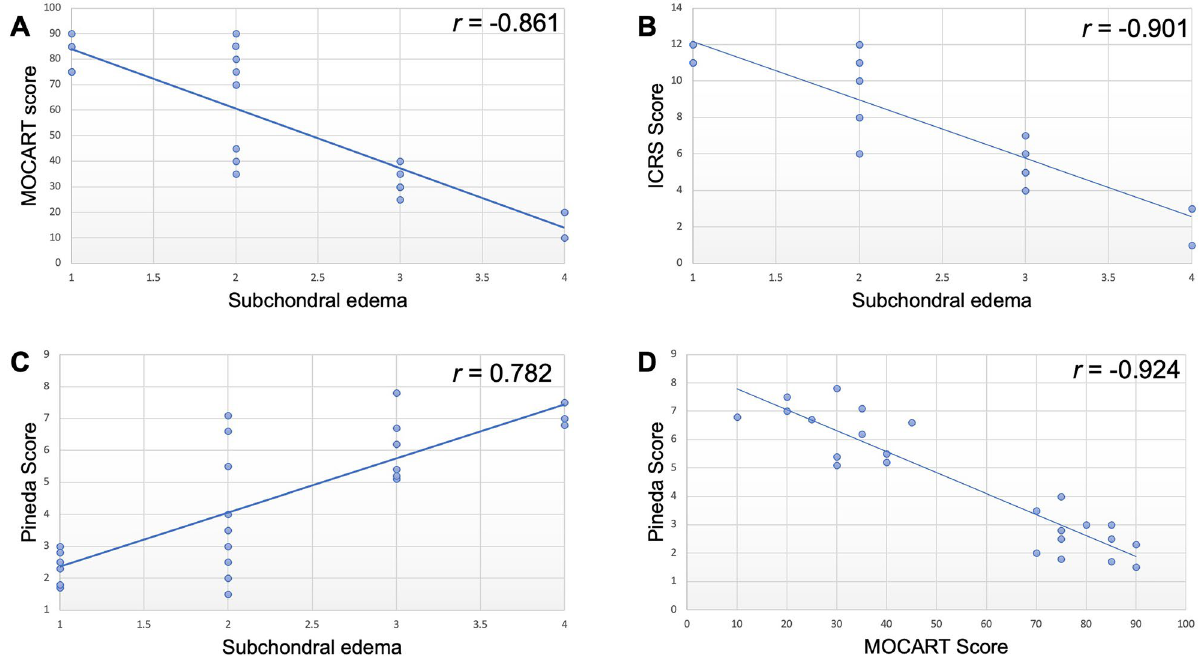
Figure 3. Correlation of quantitative scores for subchondral edema at 2 weeks after MASI with quantitative scores for cartilage repair (MOCART score, ( A ) and ICRS score, ( B )) at 12 weeks and Pineda scores at 24 weeks ( C ) and correlation of the quantitative scores for Pineda scores at 24 weeks with quantitative scores for cartilage repair (MOCART score) at 12 weeks ( D